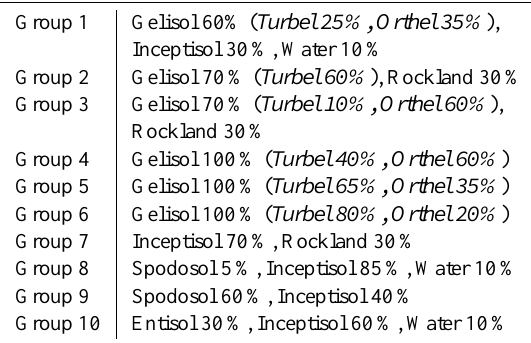
Table 1. Description of sediment clasification, percentages are a representative